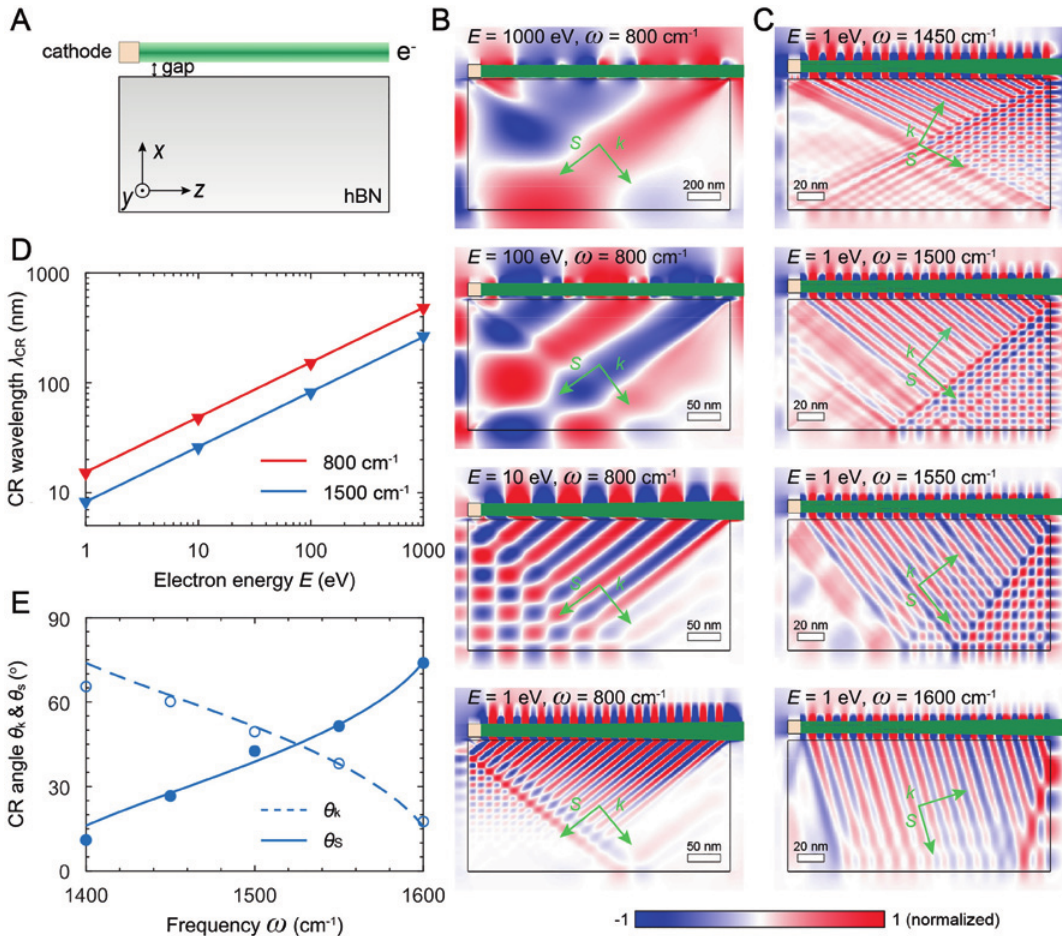
Figure3: (A)Schematicofsimulationmodel;(B)CR( E z fi eldcomponent)atfrequency ω =800cm − 1 generatedusingelectronenergies E =1000, 100, 10, and 1 eV; (C) CR ( E z fi eld component) generated at frequencies ω = 1450, 1500, 1550, and 1600 cm − 1 with electron energy E = 1 eV; (D) Simulated (triangles) and analytical (lines) results of CR wavelengths in hBN with electron energies varying in the range E = 1 – 1000 eV at frequencies ω = 800 cm − 1 (red) and ω = 1500 cm − 1 (blue); (E) Simulated (circles) and analytical (lines) results of CR angles in hBN with frequencies of ω = 1400 – 1600 cm − 1 when electron energy E = 1